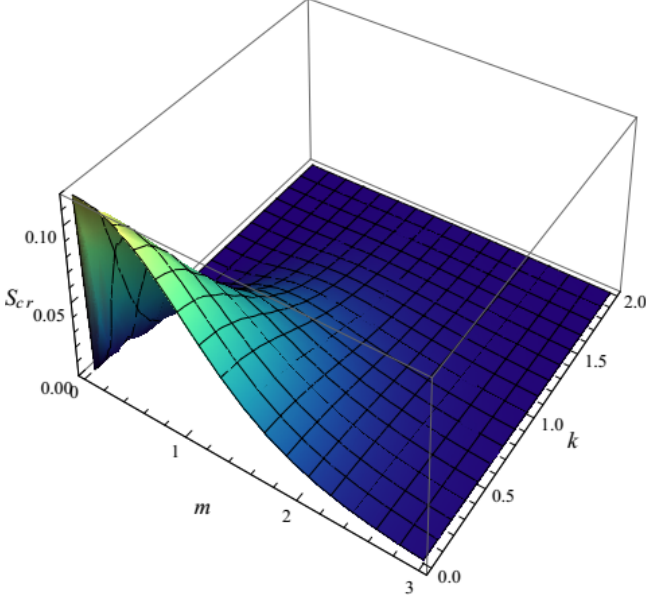
Figure 1. Particle creation entropy, S cr , as a function of momentum k and mass m for fixed values a = 1.5, b = 1, c = 0 and λ =